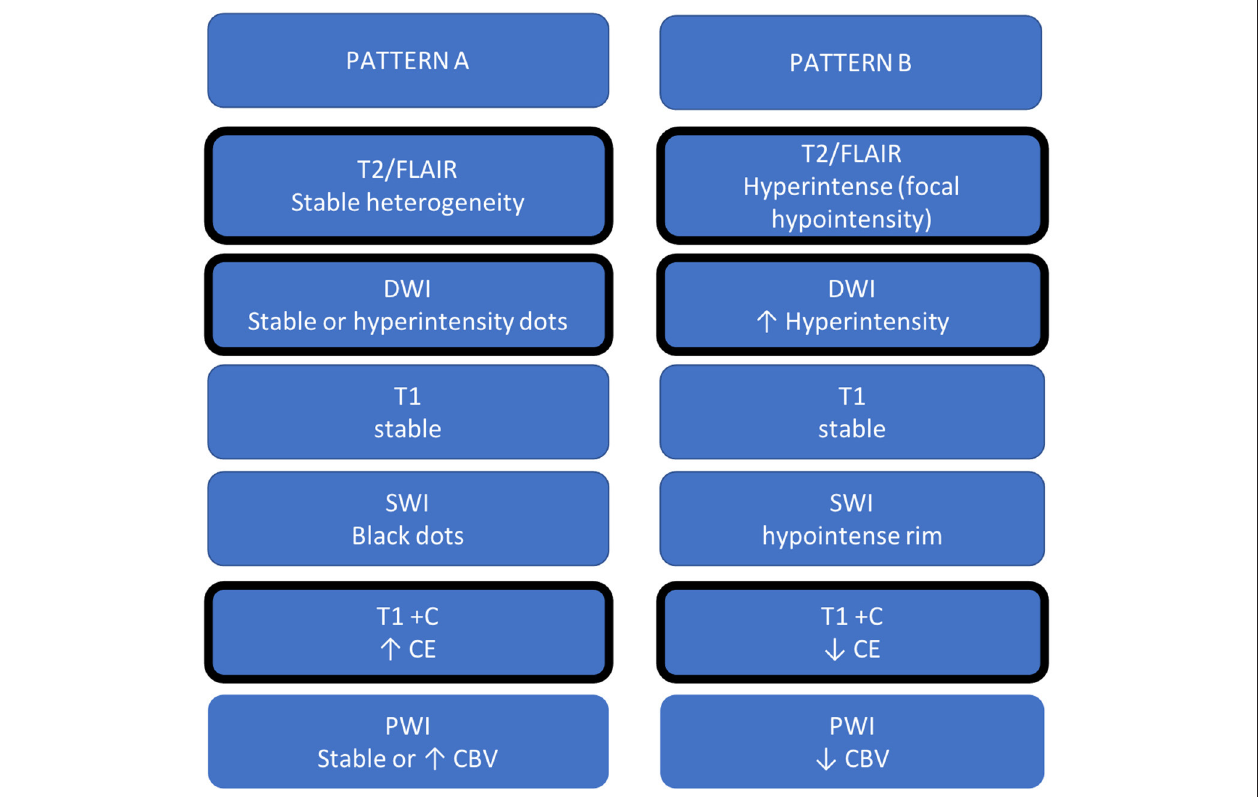
FIGURE 3 | Summary table of MRI changes during REG. The patterns defined as A and B are divided into two columns, and the MRI sign changes most frequently reported in the literature have been graphically identified with a thicker cell